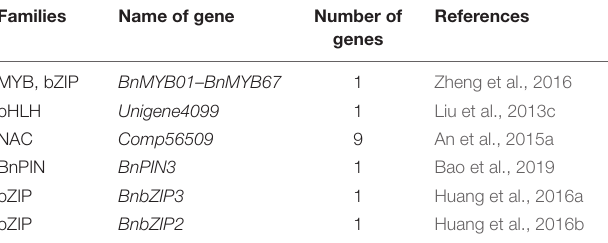
TABLE 3 | List of different transcription factors/genes involved in drought stress (DS) tolerance in ramie.